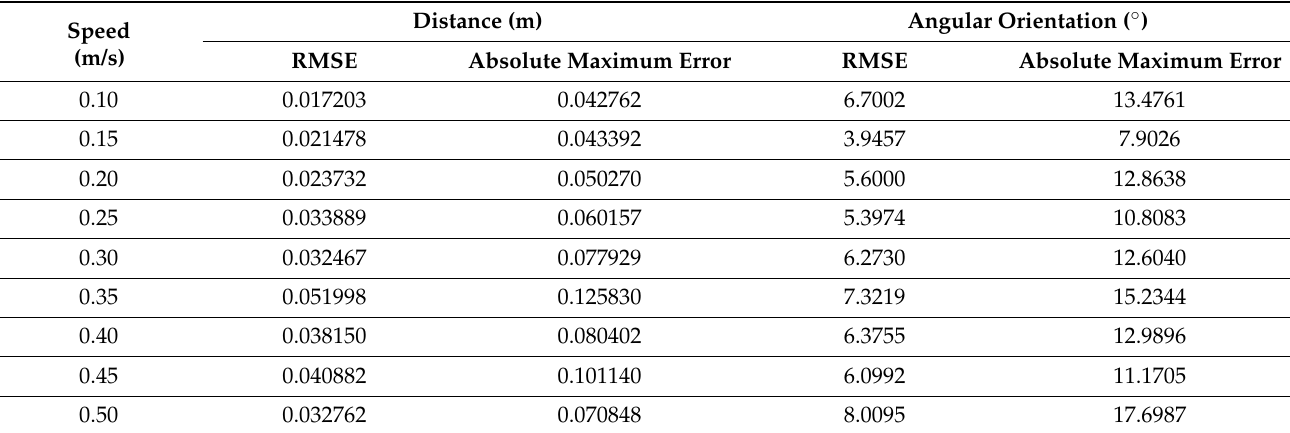
Table 1. Path-tracking errors obtained in the case of performing a circular target trajectory (Figure 7a). Speed